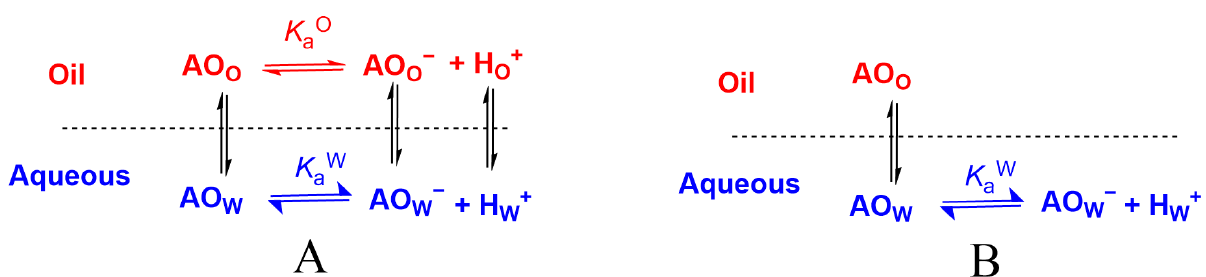
Figure 7. Distribution of an ionizable antioxidant AO in a biphasic oil–water system. ( A ) Assuming that ionization can take place in both phases. ( B ) Assuming that ionization only takes place in the aqueous phase. K aW and K aO are the ionization constant of the antioxidant in the aqueous and oil phases, respectively.